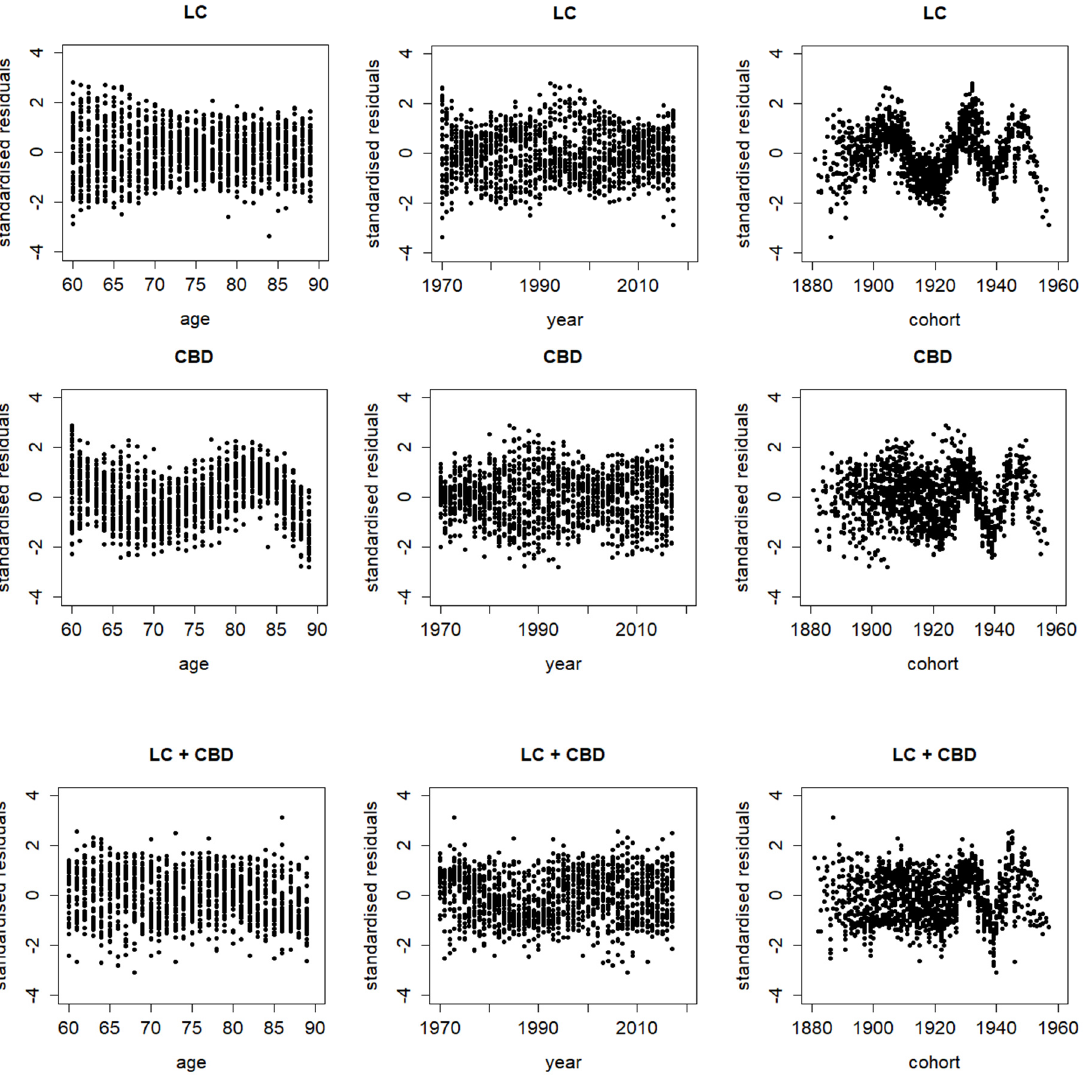
Figure 3. Standardised residuals by age, calendar year, and cohort year from Bayesian Lee–Carter model (alone), CBD model (alone), and mixture model.